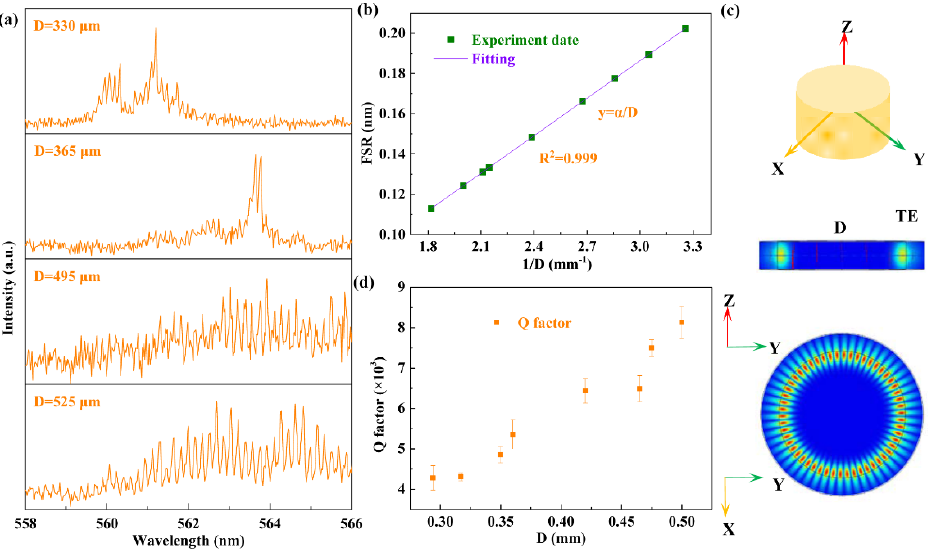
Figure 3. ( a ) The WGM modulation in four microfluidic channels with different diameters above the threshold. ( b ) The relationship between FSR and 1/D, the solid line is fitted with the Equation (2). ( c ) The structure diagram of the microfluidic channel, the cross section of electric field distribution of TE mode. ( d ) The relationship between Q factor and various diameters.